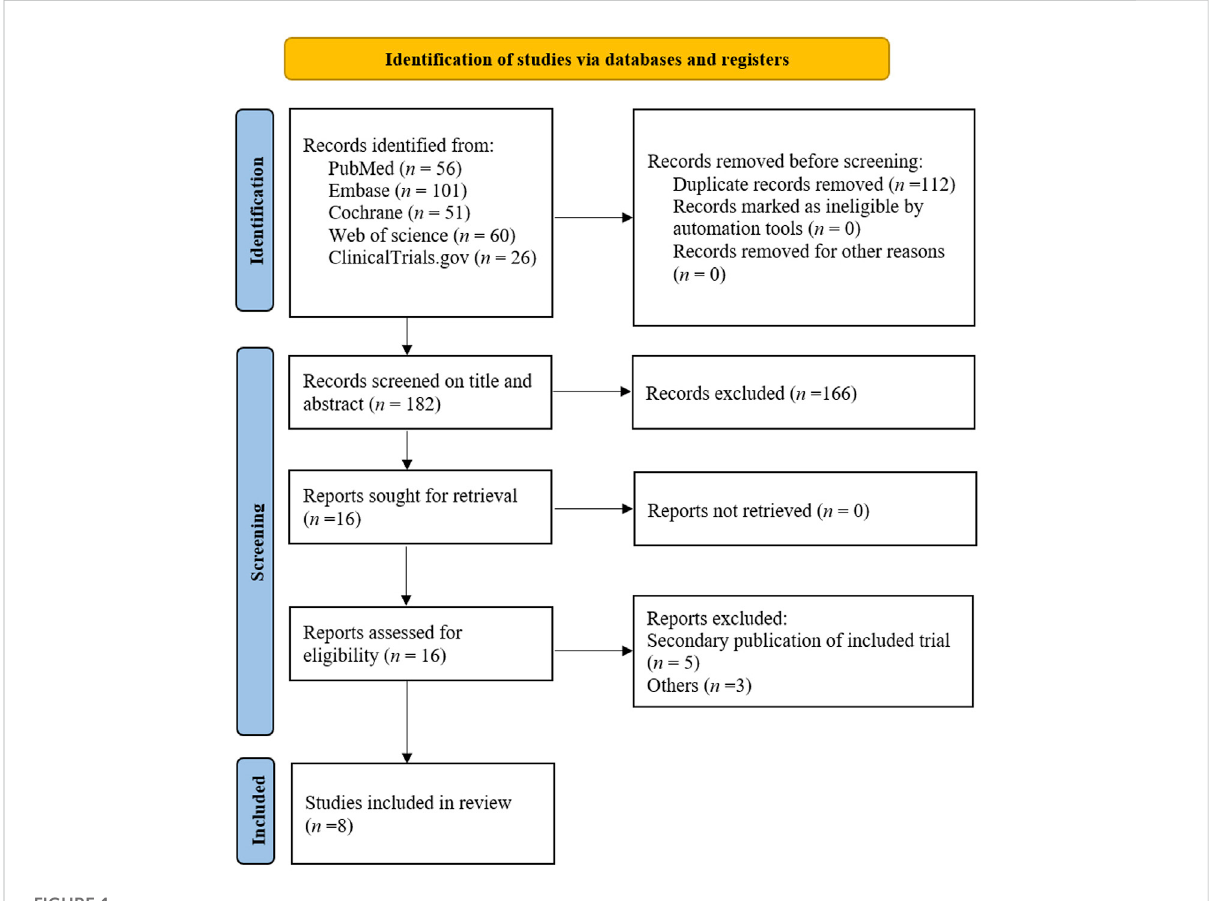
FIGURE 1 PRISMA fl owchart of literature search for eligible